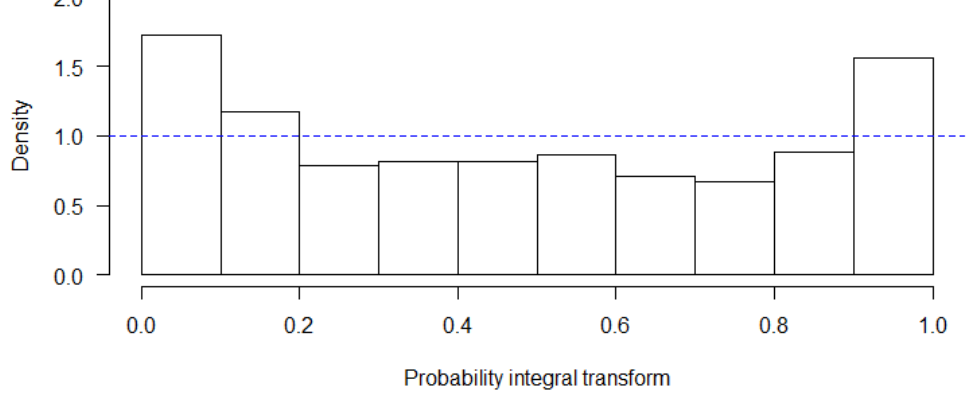
Figure 5. Probable integral transform (PIT) histogram testing for data uniformity of the generalized autoregressive conditional heteroscedasticity (GARCH) time series count model.